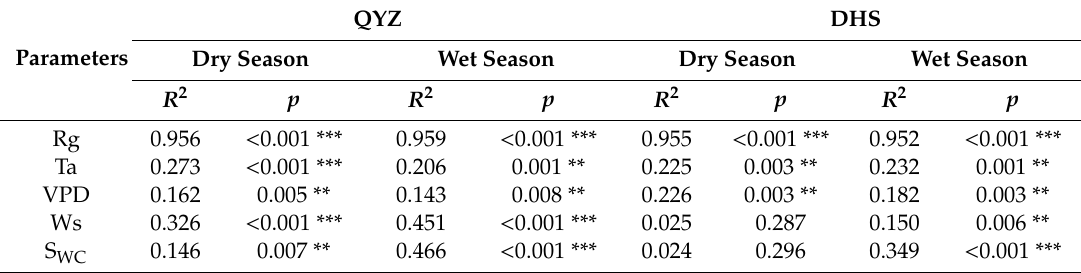
Table 3. Dominant influencing factors for the variation of ∆ T in the dry and wet seasons at the QYZ and DHS